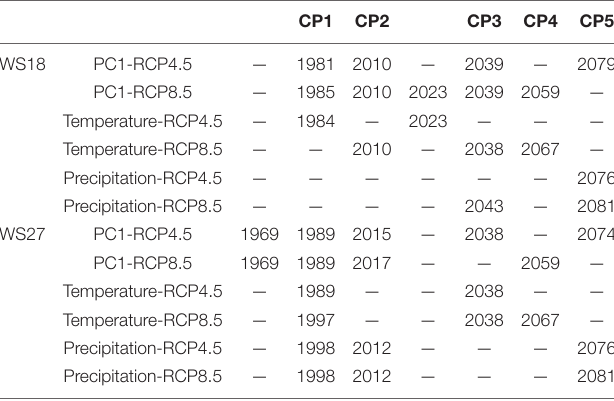
TABLE 4 | Change points of the scores of the first principal components (PC1s) and climate (temperature and precipitation).